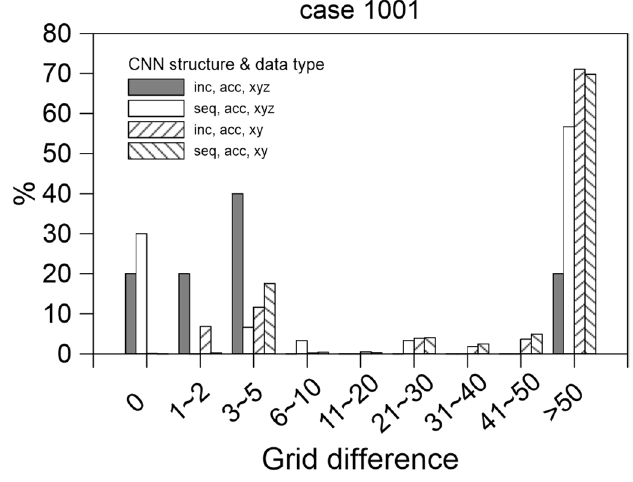
Figure 16. Difference in the maximum flooding depth position when using various deep learning models to make predictions for a single rainfall event.